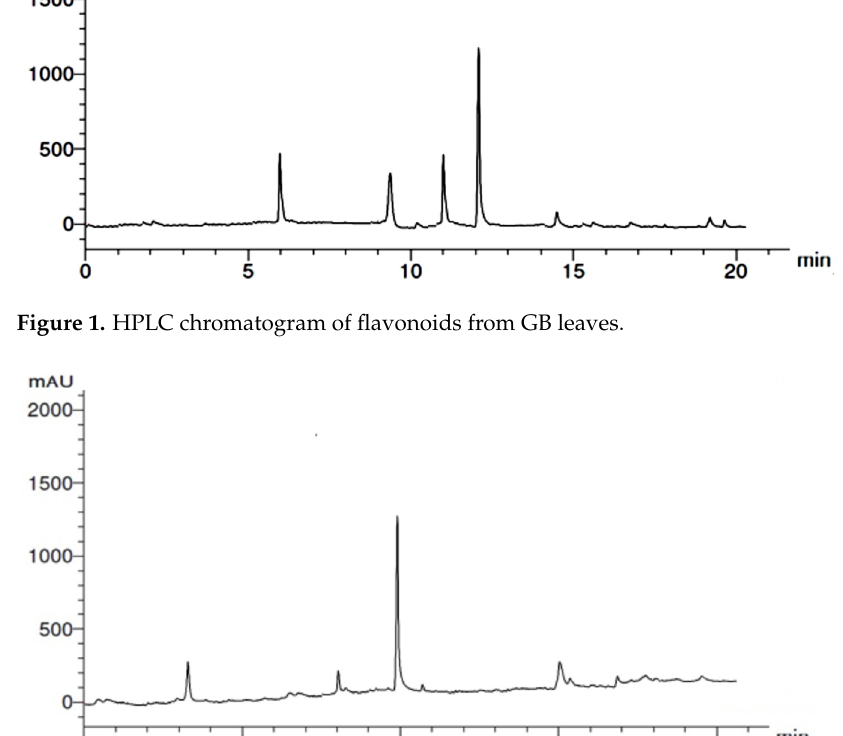
Figure 2. HPLC chromatogram of phenolics from GB leaves .